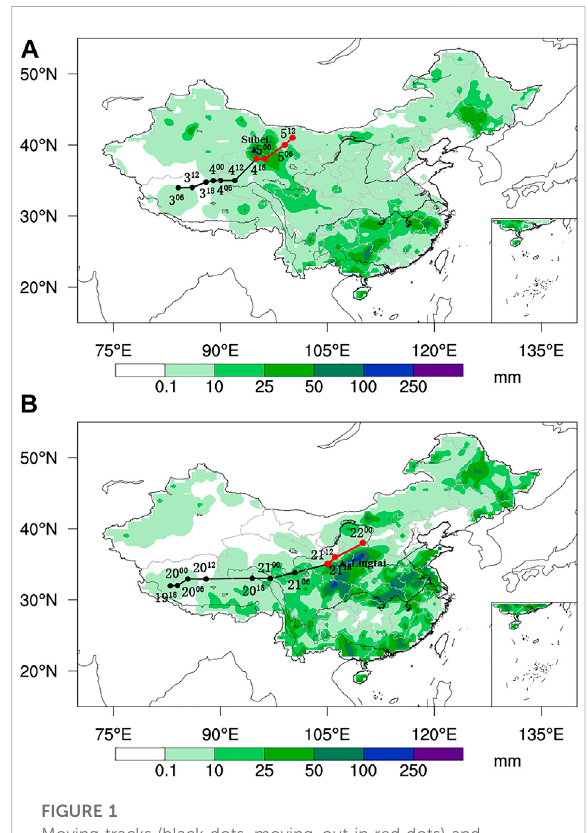
FIGURE 1 Moving tracks (black dots, moving-out in red dots) and accumulated daily precipitation (shaded) in 3 – 5 June 2012 (A) and 19 – 21 July 2013 (B) (marked as vortex position corresponding to date in the superscript and time in the subscript, ▲ : precipitation maximum station) based on ERA-Interim reanalysis datasets and